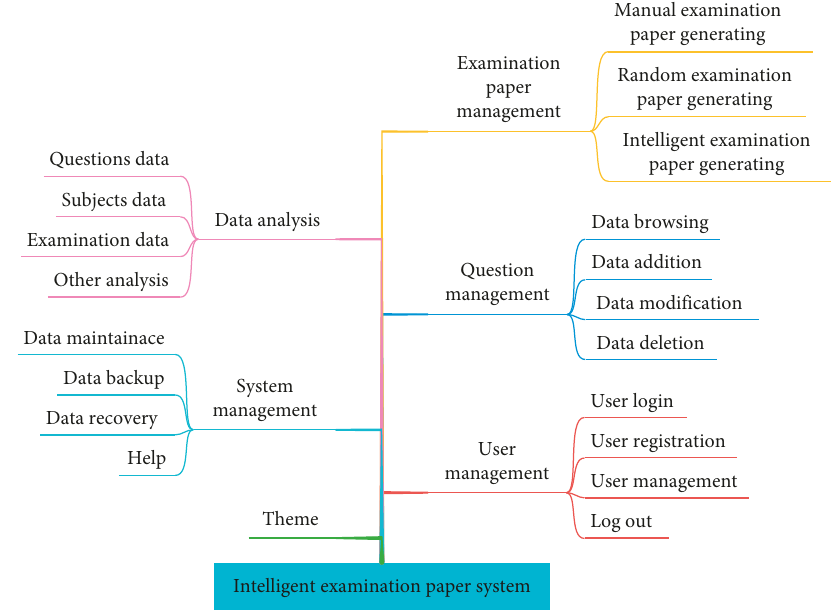
Figure 7: Structure diagram of the test paper composition system.